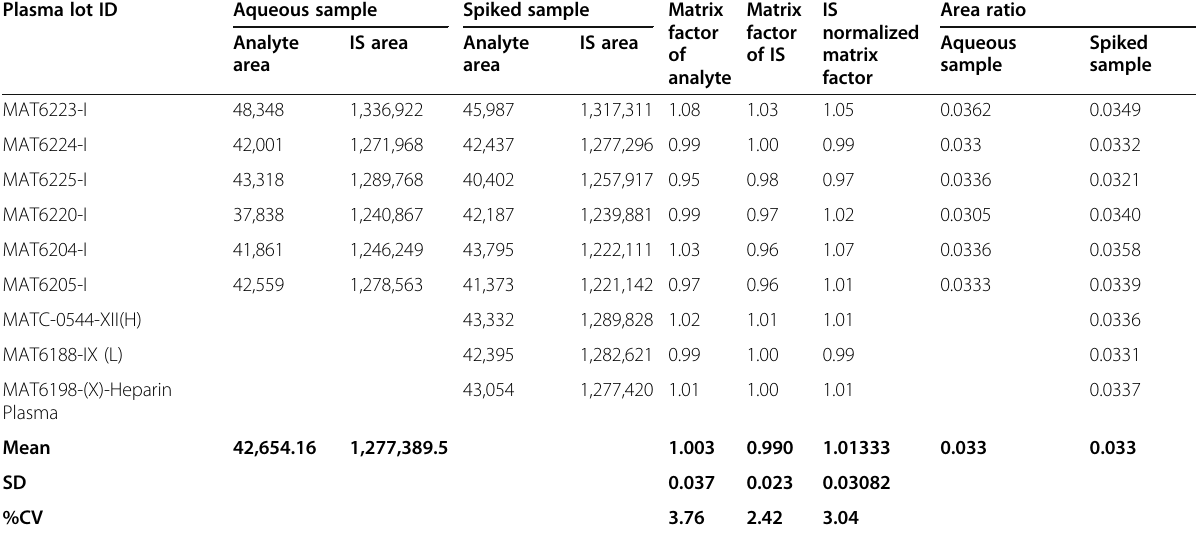
Table 3 Matrix effect and matrix factor for bexarotene at LQC level Plasma lot ID